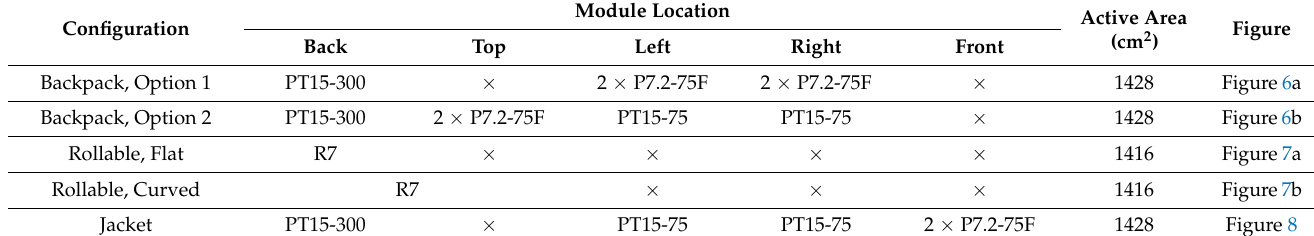
Table 6. PV module set configurations investigated.